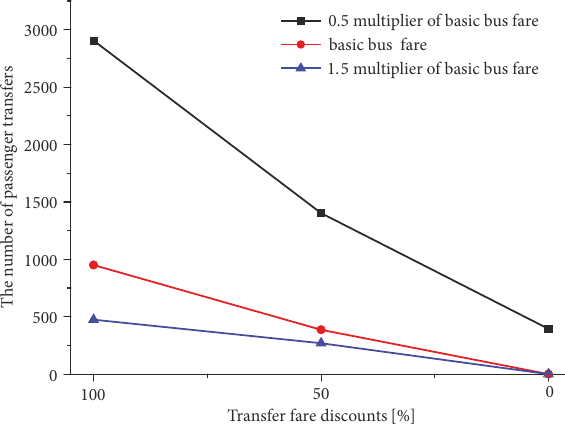
Figure 5. Effects of time-based fares with transfer discounts on the number of transfers